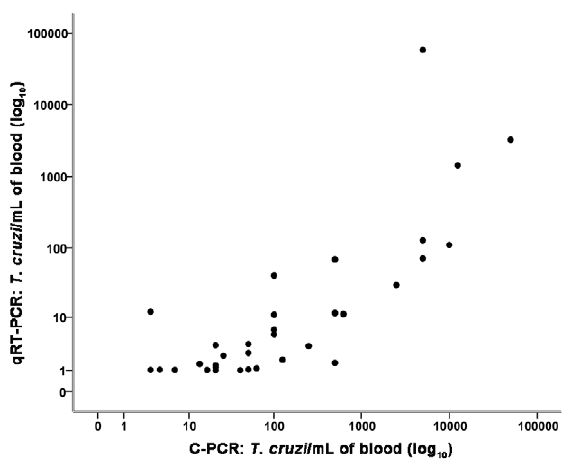
Figure 5. Correlation between the number of parasites/mL of blood (qRT-PCR) and CD4 + /CD8 + T cell ratio. Spearman correla- tion index ( r s )= 2 0.484, P =0.007 by analysis of 30 samples from patients infected with HIV/ T. cruzi with and without Chagas disease